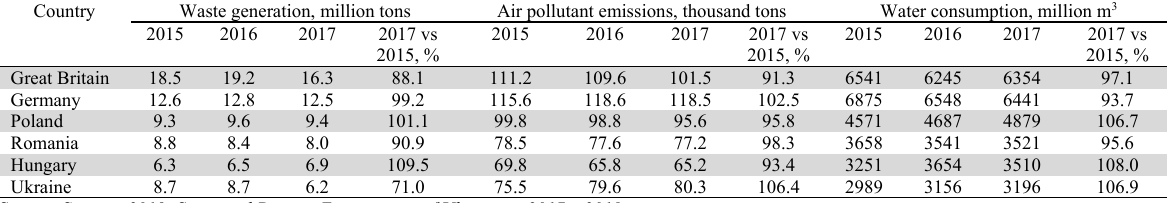
Country Waste generation, million tons Air pollutant emissions, thousand